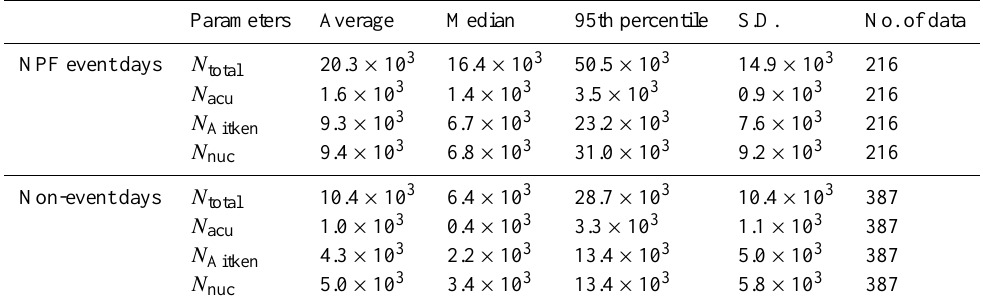
Fig. 6. Time series of measured parameters for summer 2012. From bottom to upper panels are (i) particle size distribution, (ii) total particle number concentration ( N total ) and (iii) wind direction (wind vector) and speed (WS). Table 2. Statistic of particle number concentrations measured during NPF event days and non-event days. Unit: cm − 3 for N total , N acu , N Aitken and N nuc